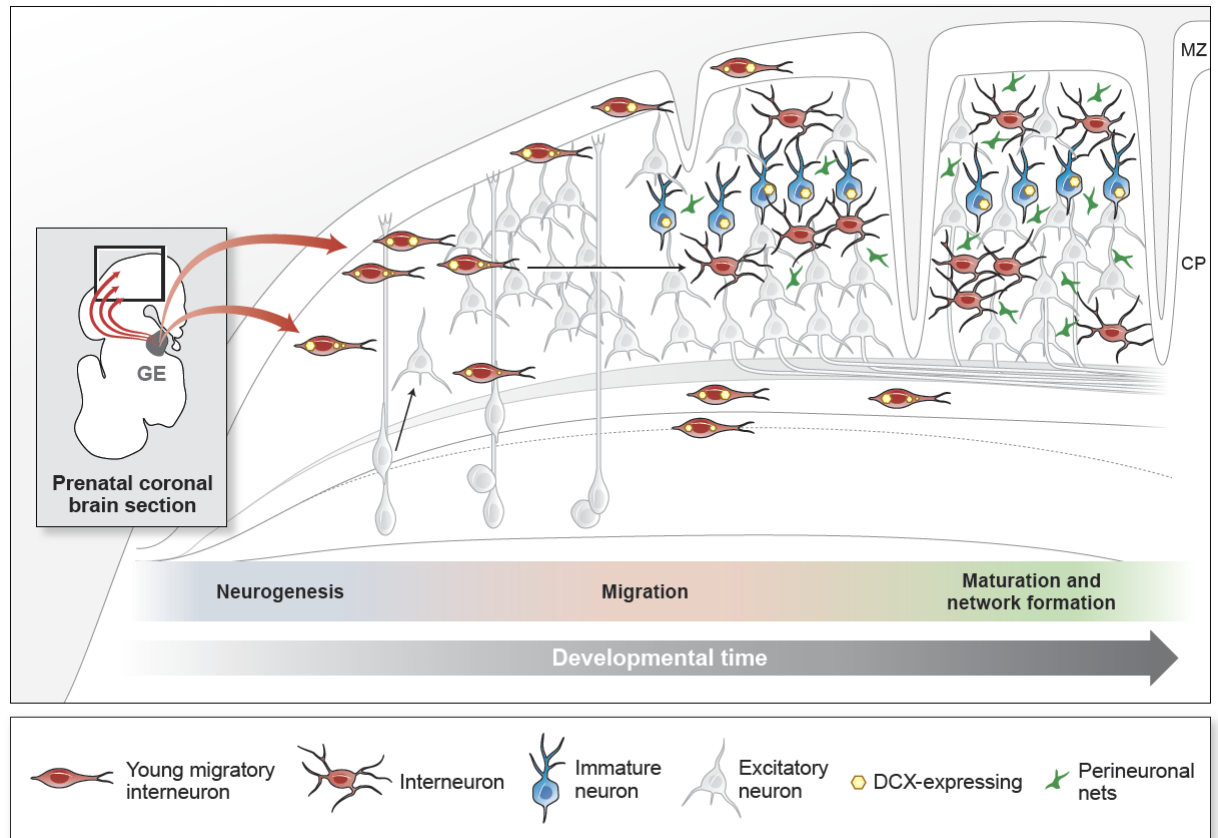
Figure 1. The developmental processes of cortical GABAergic inhibitory neurons. Inhibitory neurons (interneurons) contribute to 20–30% of the total cortical neurons. They are generated in the ventral embryonic brain in a region called the ganglionic eminence (GE) during mid- to late-gestation (schematic shows a representative coronal section of the prenatal brain). Excitatory cortical neurons, in contrast, are generated from radial glial progenitors at the end of the first trimester and establish the cortical plate in an inside–out manner (shown in gray). Interneurons migrate from the GE and appear in the cortex early in the second trimester. Young migratory interneurons (shown in red) have a leading process and express DCX (yellow) as they migrate into the developing cortical plate (CP). The CP is the precursor to the multi-layered cortical structure. Interneuron migration into the cortex extends to the early postnatal period in gyrencephalic brains. Interneurons in the cortex increase their morphological complexity and decrease DCX expression with maturity. In adulthood, the DCX-expressing population (shown in blue) remains in cortical layer 2. Their cellular identities and functions are unknown. Within the developing cortical circuit, synapse maintenance is influenced by sensory stimuli and mediated by extracellular matrix components, such as perineuronal nets (PNNs) (green). Synapses are stabilized as PNNs increase with age. Progression from prenatal to postnatal ages is represented by the grey arrow (developmental time) directed left to right. MZ, marginal zone; CP, cortical plate.